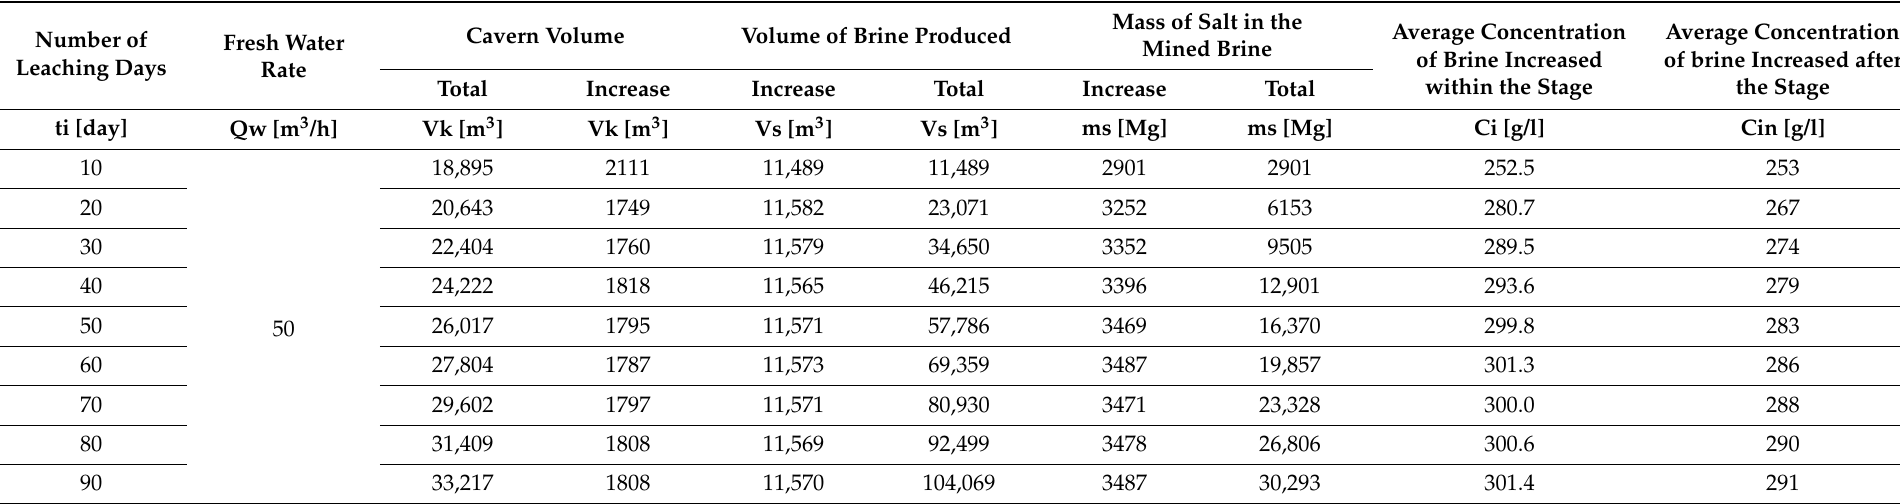
Table 5. Development of stage II, 1 phase of the leaching process directly from the well—Stage II/Scenario 1 (S II/S